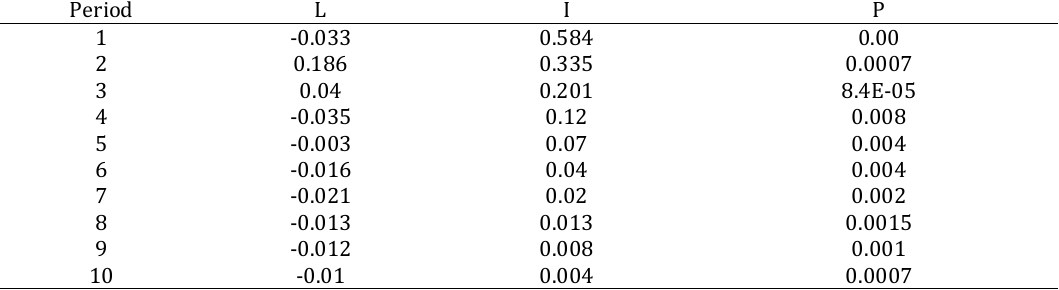
Table 5: The response of indemnities variation to a shock in